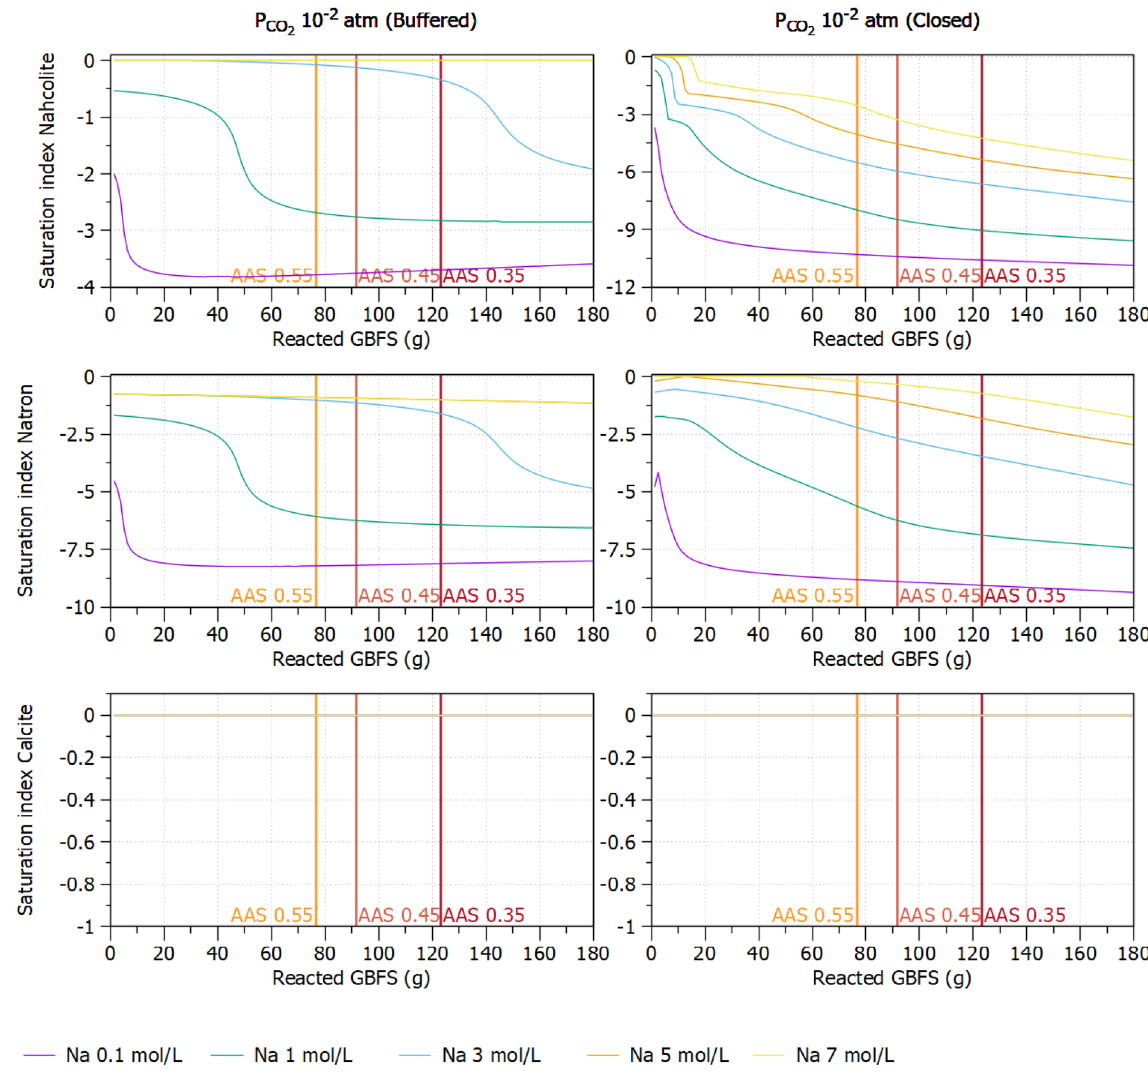
Figure 9. Saturation indices of nahcolite (top), natron (middle) and calcite (botom) in 1 l of water (20 °C) for 5 different Na concentrations. Vertical dashed lines indicate the amount of reacted GBFS determined by 29 Si MAS NMR for 3 w/b